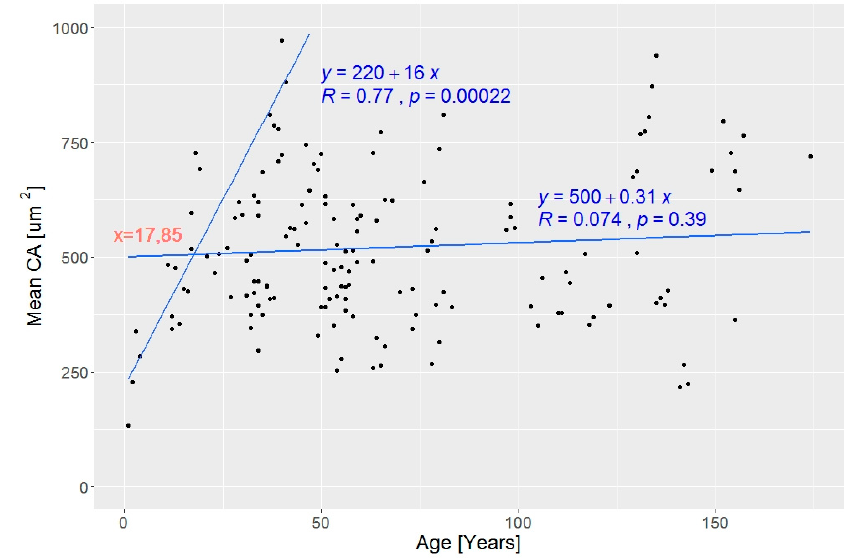
Figure 2. Linear regressions (blue) for the mean annual tracheid area (CA) parameter for all sites as a function of cambial age. The intersection of the two regression lines (red) represents the boundary point between the juvenile and mature wood as it was suggested by Yang et al. [59].